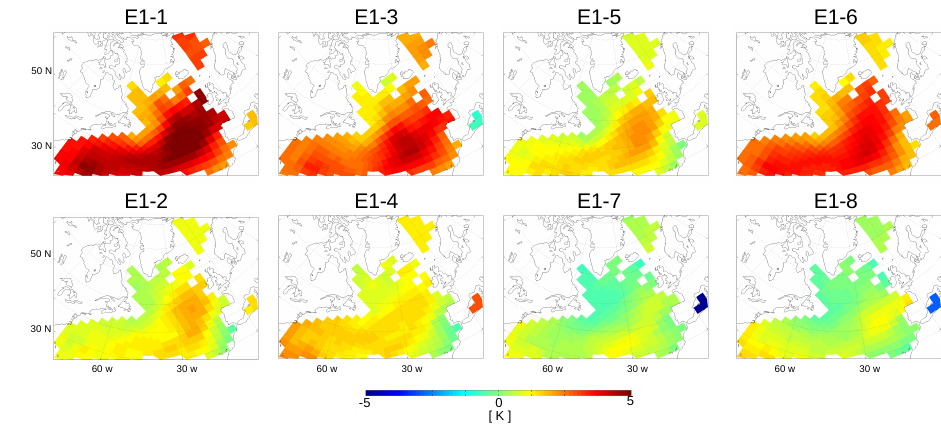
Fig. 2. Anomalies of temperature at the depth of 2000m in E1-1–E1-8 compared to Target 1.